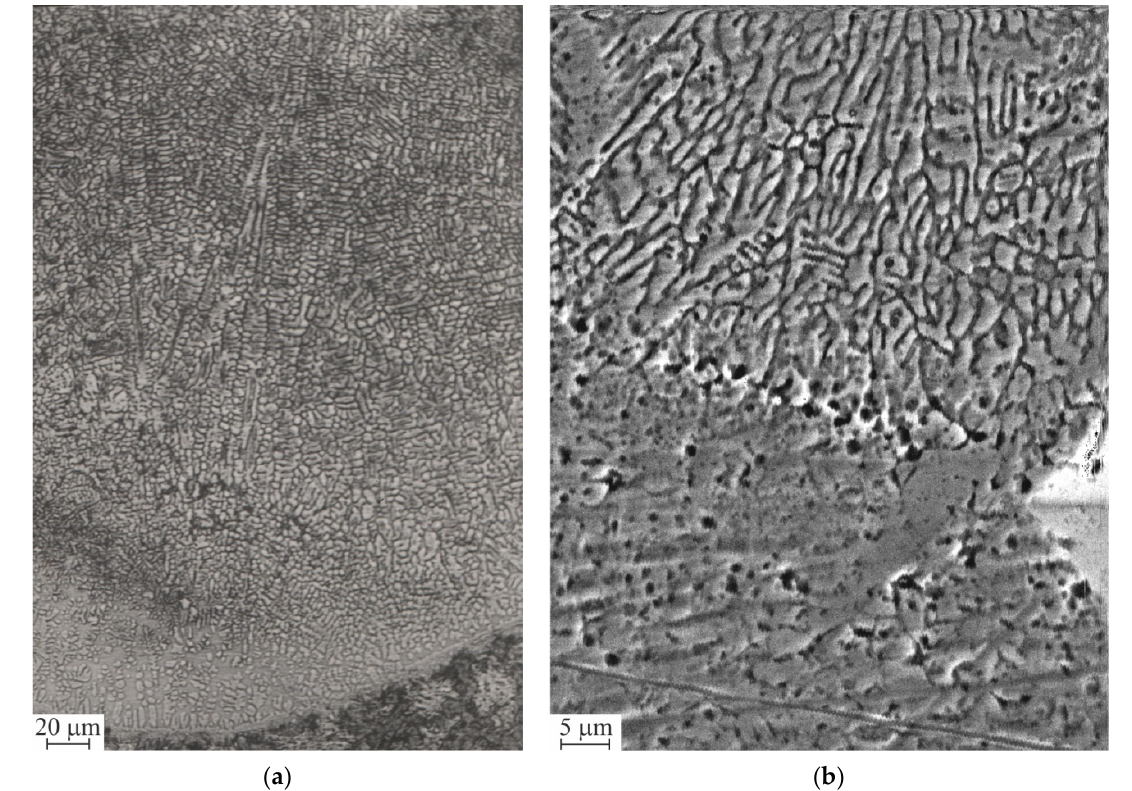
Figure 6. ( a ) Optical and ( b ) SEM images of ( a ) AISI 420 and ( b ) AISI 304 steels after laser alloying with a plaster of 15Fe + 30Ni + 20B + 10Si + 25% liquid glass.